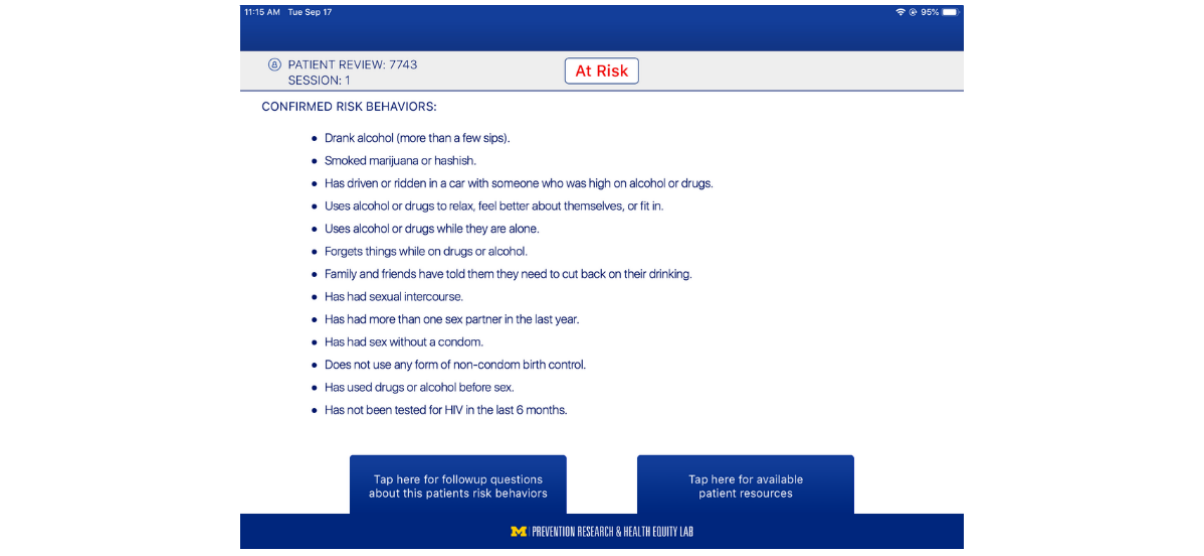
Figure 3. Clinician-facing Storytelling 4 Empowerment application highlighting youth risk